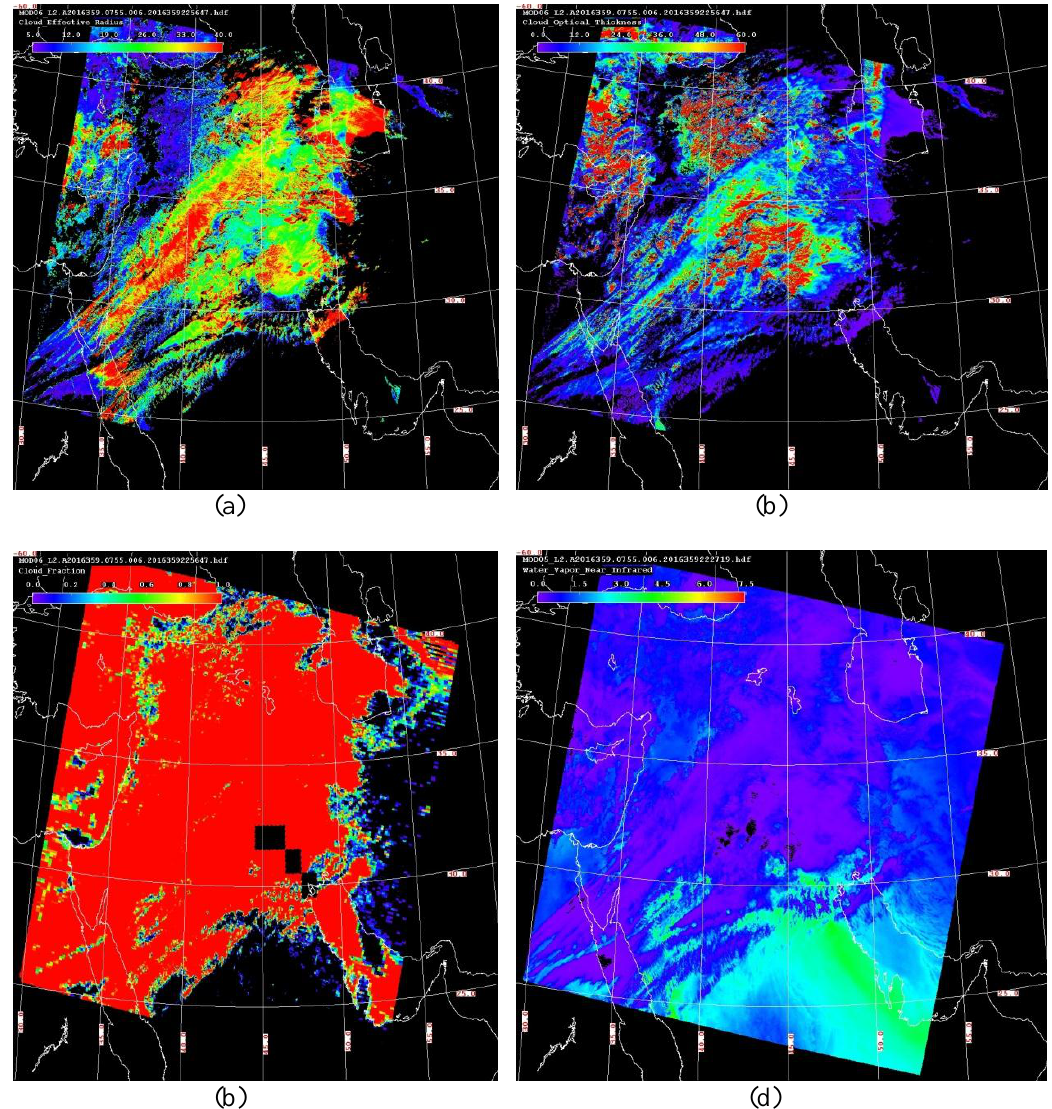
Fig. 14: a) Illustration, cloud effective radius, b) the thickness of clouds in both layers band 7 (2.1 μm ) were used, c) represent the cloud fraction, d) show how much water vapor over